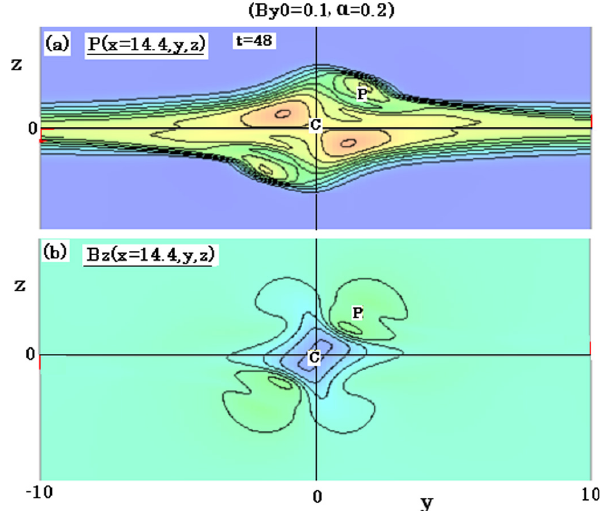
Fig. 14. Distributions of the plasma pressure P (contour interval of 0 . 15) and B z (contour interval of 0 . 1) in the cross section at x = 14 . 4 at t = 48 for the case of B y0 = 0 . 1 and α = 0 . 2, where the regions P and C are